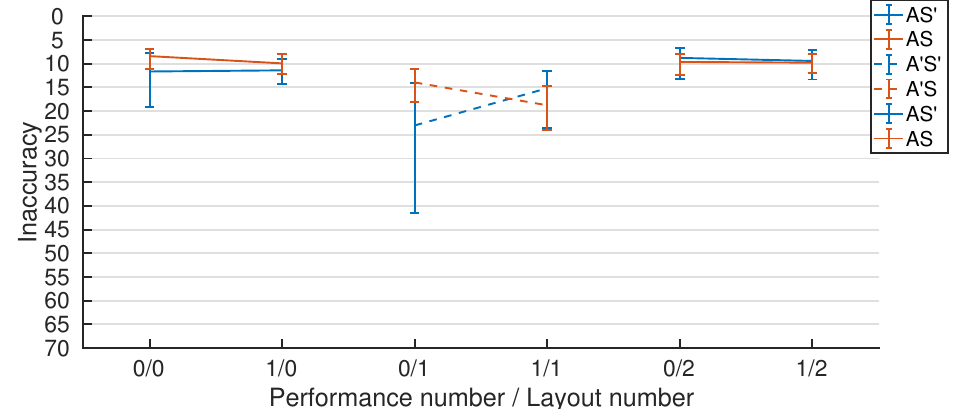
Figure 4. Inaccuracies, averaged across participants, for the scale retention task. The higher the line, the more accurate the average performance. The bootstrapped confidence intervals cover a 95% range. Adjacent layouts have solid lines, nonadjacent have dashed lines. Sheared layouts have orange lines, unsheared have blue lines. The first performance is coded 0, the second is coded 1; the first layout is coded 0, the second is coded